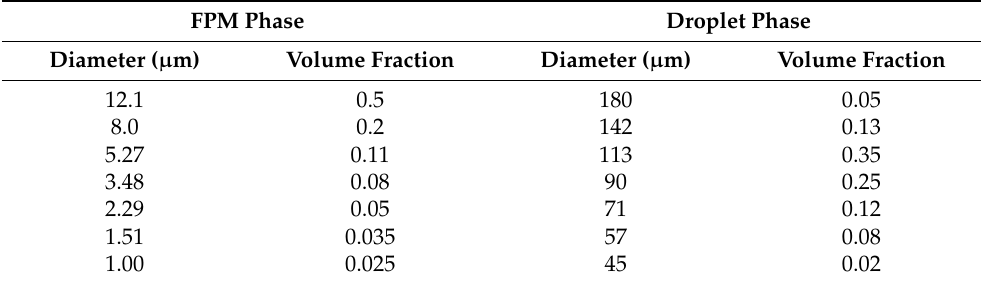
Table 1. Size distribution of each